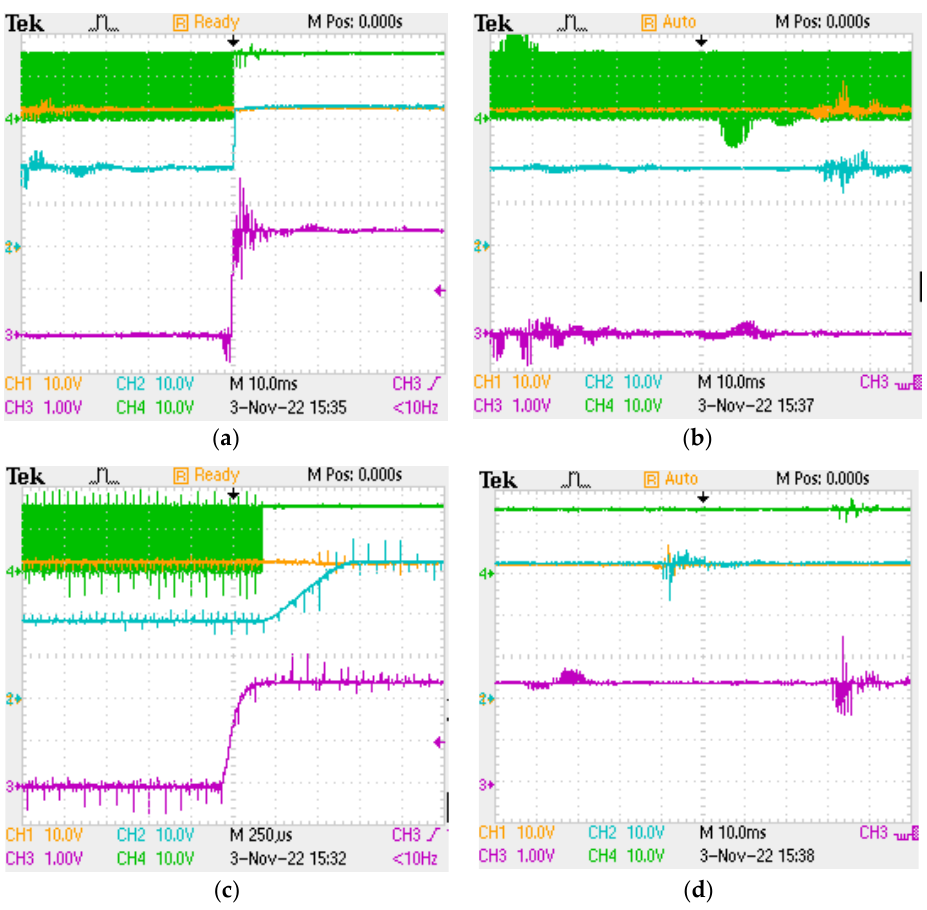
Figure 20. The experimental waveforms of S 3 short-circuit fault. ( a ) Overall stages; ( b ) the waveform of three-level mode before S 3 fault; ( c ) the waveform of S 3 short-circuit fault during fault; ( d ) the waveform of two-level mode after S 3 fault.